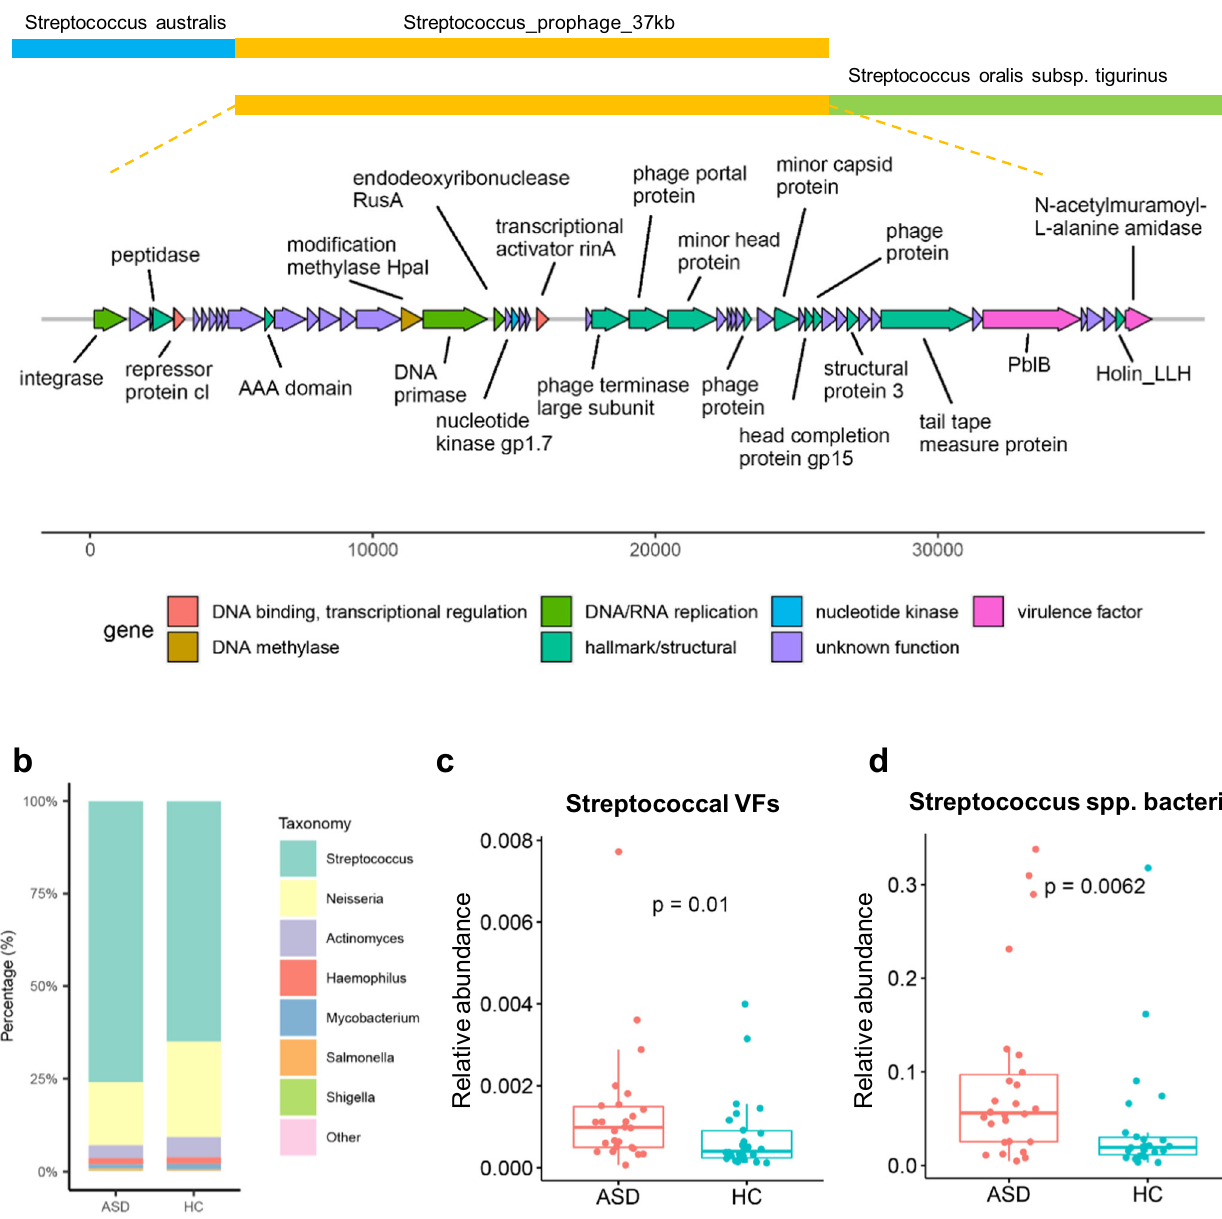
Fig. 5 Enrichment of Streptococcal virulence factors (VFs) in the oral microbiota of ASD subjects. a The genome of a 37-kb Streptococcal prophage. The upper panel shows the fl anking sequences of the prophage that come from two Streptococcus species. The lower panel is the genome structure of the prophage, where each gene is colored by its function categories, and the VFs are pink-colored. b The proportion of VFs hosted by each bacterial genus in total VF abundance between ASD and HC oral microbiota. c The relative abundance of Streptococcal VFs in the oral microbiota of the two groups (Mann – Whitney U test). d The relative abundance of Streptococcus bacteria in the oral microbiota of the two groups (Mann – Whitney U test). In Box – Whisker plots, the middle horizontal line refers to the median value, and the width of the box is the interquartile range (IQR) with 1.5 IQR Whisker manifestations are comparatively weaker, implying a more VFs also exhibits positive correlations to total ADOS scores prominent impairment of language communication from the oral (rho = 0.38) and LC scores (rho = 0.45) (Fig. 6b, Supplementary Streptococcus (Supplementary Fig. 7, Supplementary Table 7). Table 7), as well as the total abundance of Streptococcus spp. Interestingly, whether Streptococcus species and their phages, bacteria to total ADOS scores (rho = 0.54) and LC scores (rho = as well as VFs in the gut microbiota, are associated with ASD 0.42) (Fig. 6c, Supplementary Table 7). The consistently strong appears uncertain. The intestinal abundance of Streptococcal correlations support the proposal for a potential contribution of phages, VFs, and Streptococcus spp. bacteria are weakly or even oral Streptococcus and their phages and VFs in ASD pathogenesis negatively correlated to the ADOS total score or scores of each and evident effects on aggravating severity of the disorder. The domain (Supplementary Fig. 8). The irrelevance of the gut correlations to other scores of ADOS domains and other clinical